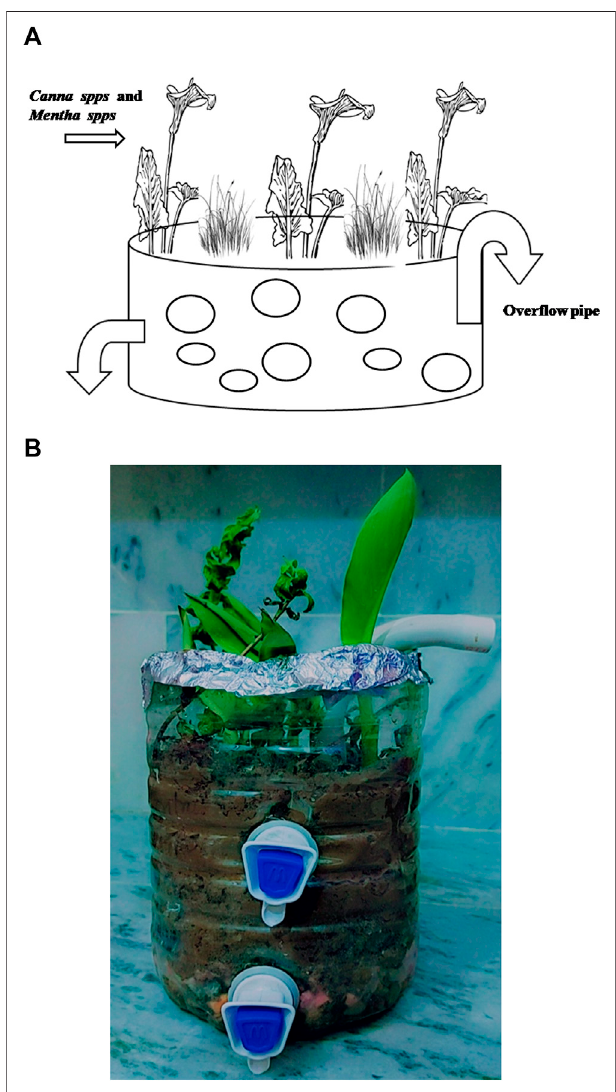
FIGURE 1 | (A) Proto-type constructed wetland. (B) . Execution of the prototype constructed wetland.